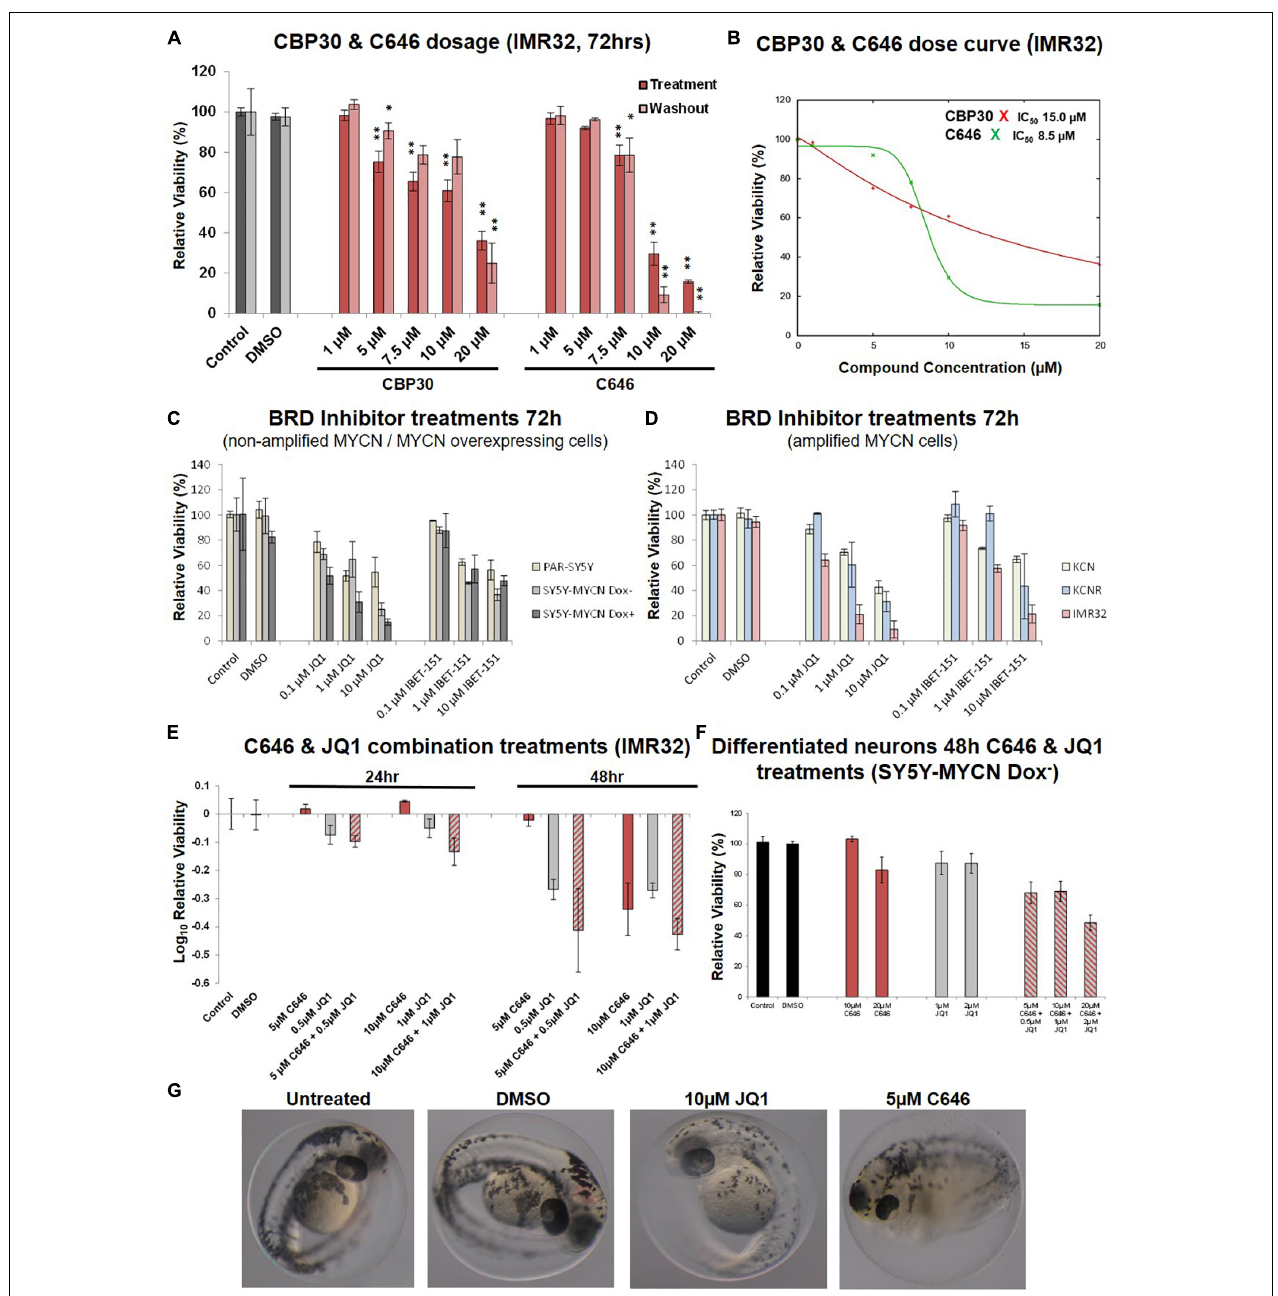
FIGURE 4 | Dose curves, combination treatments, neuronal and phenotypic screens. (A) Expanded dose response assessment of the inhibitors C646 and CBP30 in MYCN amplified IMR32 cells. Relative cell viability was determined using Alamar Blue assays. Viability results immediately after the 72 h treatment (Treatment) and after an additional 48 h in the absence of inhibitors after treatment ended (Washout) are shown. Paired sample t -test values are designated with asterisks above bars. P ≤ 0.05 - *; P ≤ 0.01 - **. Error bars indicate the mean ± SD. (B) IC 50 estimate for CBP30 and C646 for the 48h treatment of IMR32 cells. Asterisks correspond to X axis drug concentrations ( µ M) and Y axis relative cell viability (%). Curve fitting performed with IC Toolkit (http://ic50.tk/index.html). (C) Relative viability (Alamar Blue assay) upon BRD4 inhibitor treatment (JQ1 and I-BET151) of MYCN single copy cell lines, including doxycycline inducible MYCN cell line SY5Y-MYCN. (D) Relative viability (Alamar Blue assay) upon BRD4 inhibitor treatment (JQ1 and I-BET151) of MYCN amplified cell lines, including doxycycline inducible MYCN cell line SY5Y-MYCN. (E) Relative viability (Alamar Blue assay) upon combination CBP and BRD4 inhibitor treatment (C646 and JQ1) of MYCN amplified IMR32 cells. (F) Single agent and combination treatment (C646 and JQ1) of differentiated neurons (pre-inhibitor treatment, 11 day RA treated un-induced SY5Y-MYCN cells). Log 10 relative viability (Alamar Blue assay) upon 48 h treatments combination CBP and BRD4 inhibitor treatment (C646 and JQ1) of MYCN amplified IMR32 cells. Error bars indicate the mean ± SD. (G) Zebrafish embryos treated for 24 h (28 h post fertilisation [hpf]- 52hpf) with epigenetic targeting compounds (JQ1 and C646). Magnification is 10x, images from 52 hpf. Melanocytes appear black due to their endogenous melanin. Otic vesicles (large black circles) mark the anterior pole (head) of the embryos.